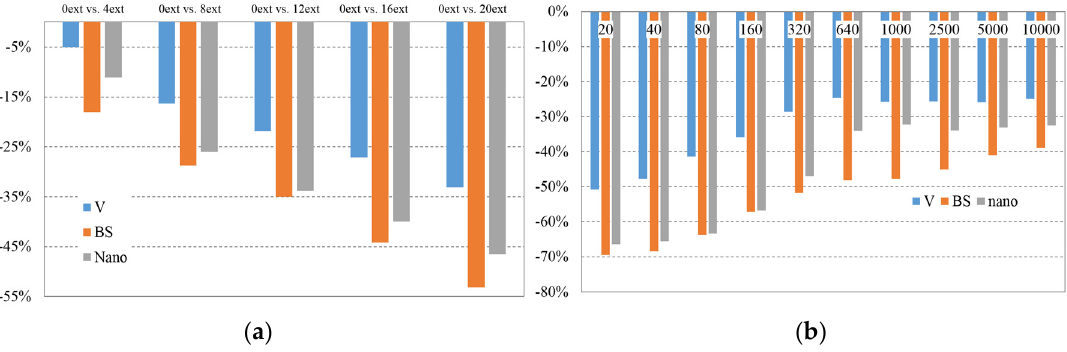
Figure 7. ( a ) Average Variation of Viscosity value @ 180 °C by extrusion batch (compared versus 0 extrusions batch); ( b ) Viscosity value variation by shear rate [compared 0 extrusions versus 20 extrusions batch] @ 180 °C.